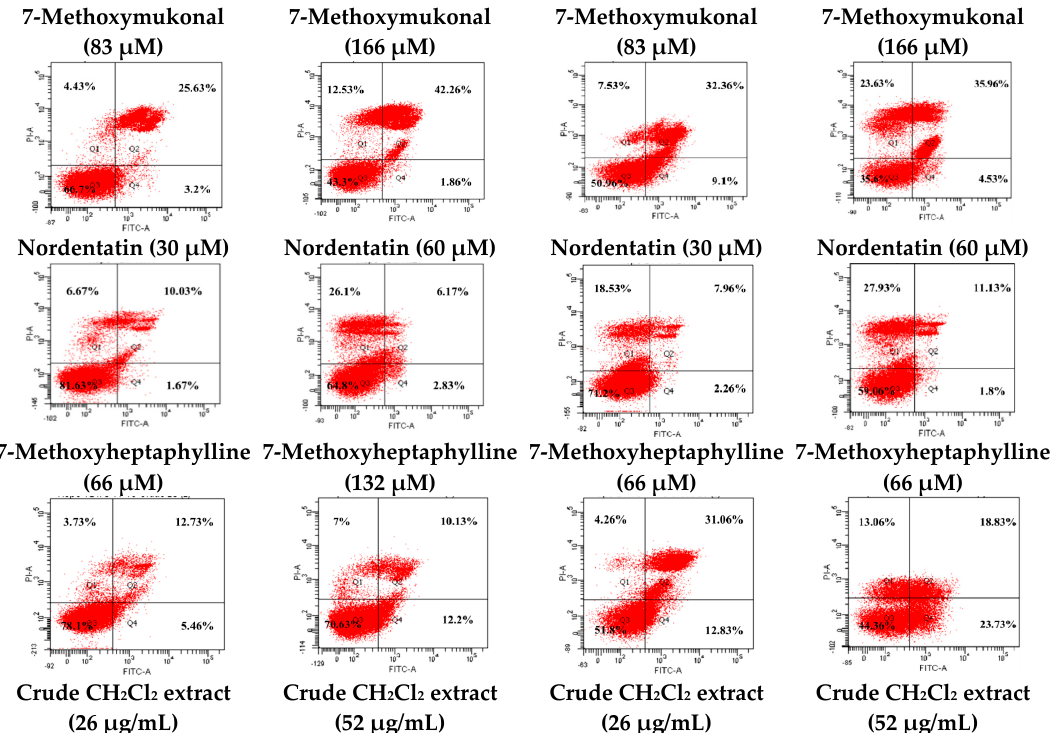
Figure 2. Flow cytometry histograms of the HepG2 cells after being treated with the isolated compounds and the untreated HepG 2 cells or control. Cells were treated at 1 × IC 50 and 2 × IC 50 concentrations for 12 and 24 h. (a)